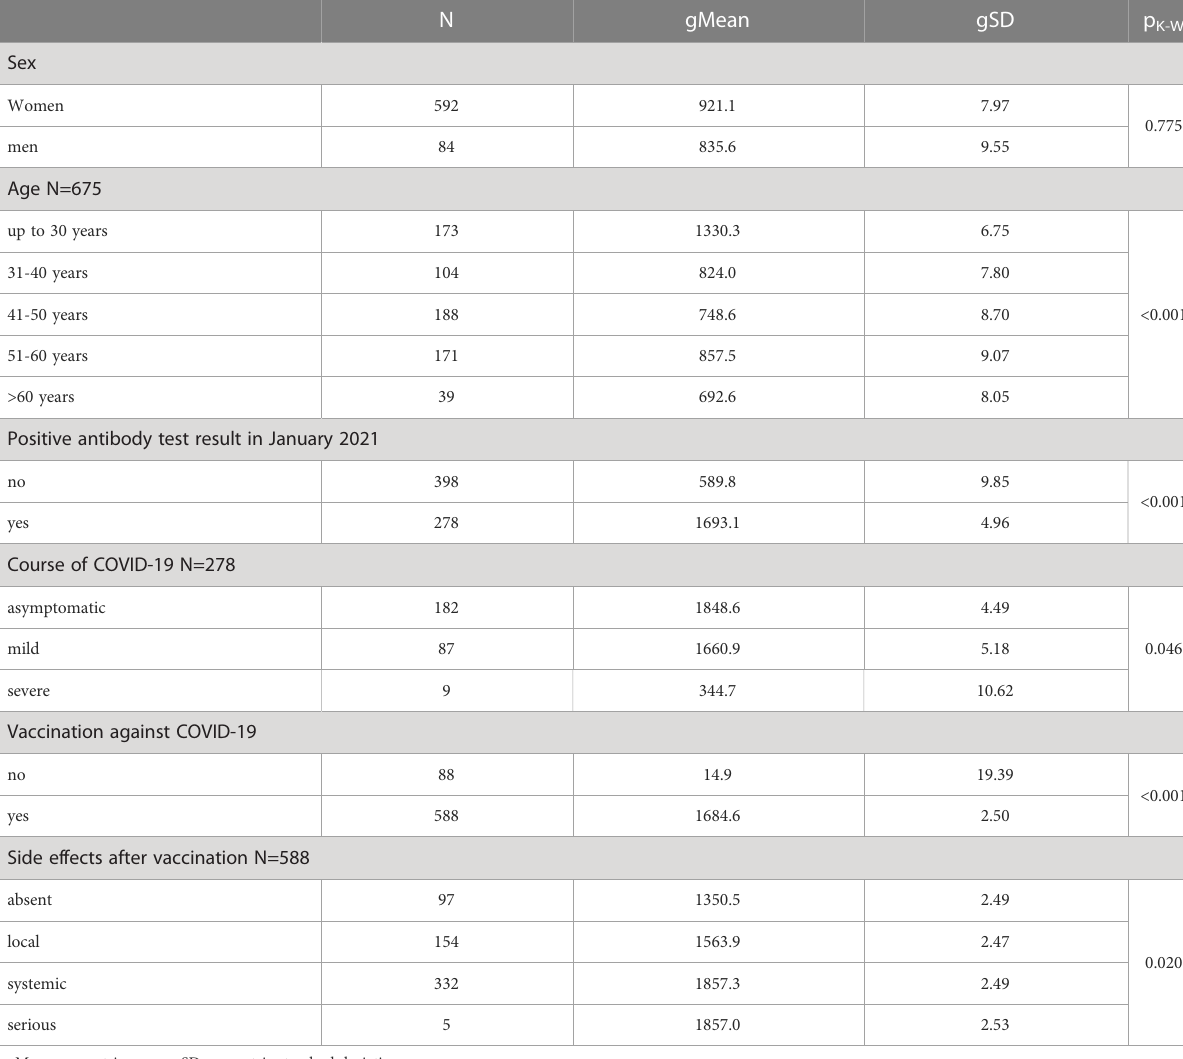
TABLE 3 Antibody levels in June (U/mL) in relation to demographics factors, positive antibody test result in January 2021 and vaccination